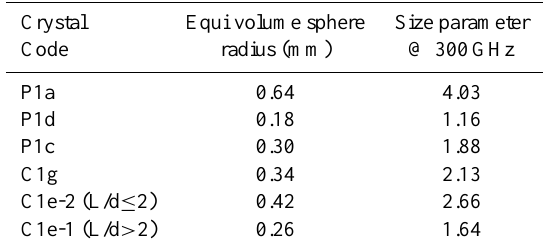
Table 3. Equal volume sphere radius of the modeled ice crystals and size parameter at 300GHz